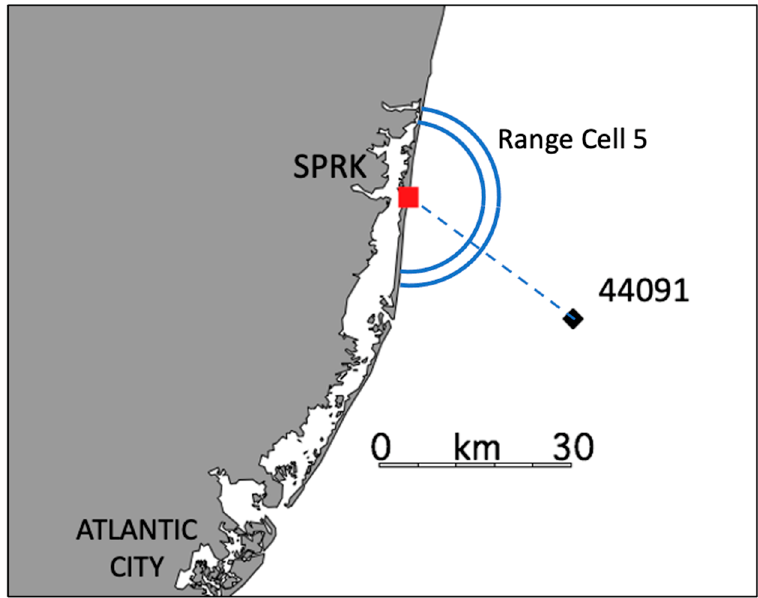
Figure 6. The coastline around the SeaSonde located at Seaside Park (SPRK), New Jersey, showing the positions of the radar and the NOAA wave buoy 44,091. Also shown is the radar Range-cell 5 of width 3 km: Radar echo from Range-cell 5 was analyzed to give the following results.